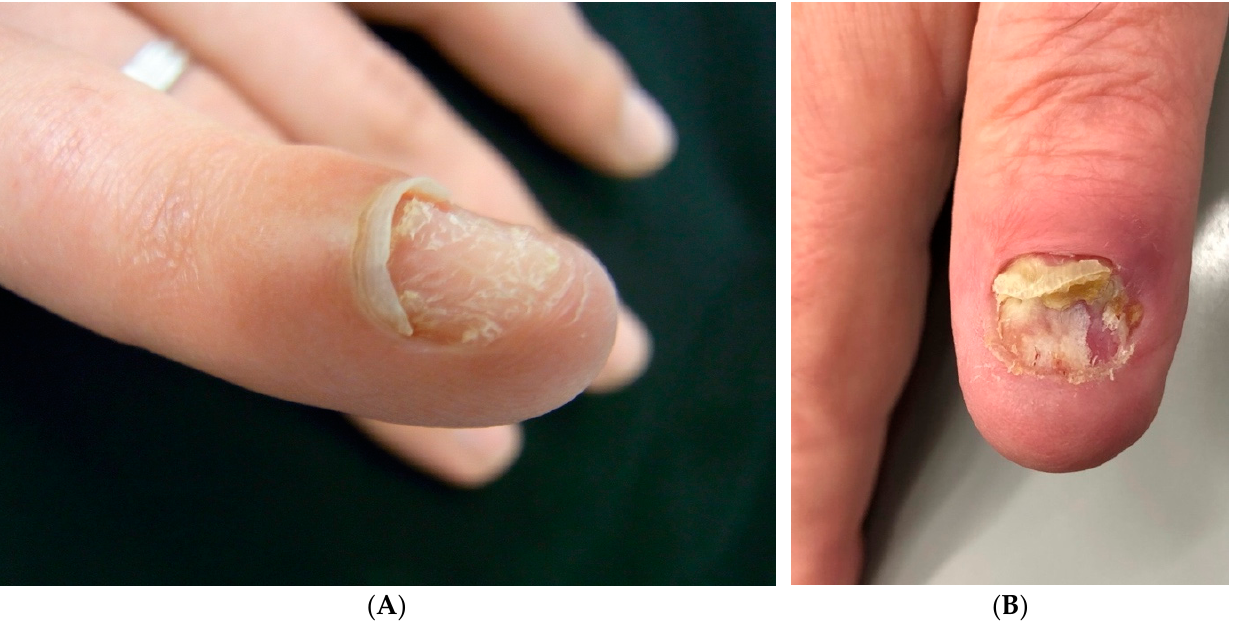
Figure 2. Single-digit onychomycosis. ( A ) Index finger of a 35-year-old woman. ( B ) Thumb of a 65-year-old man.